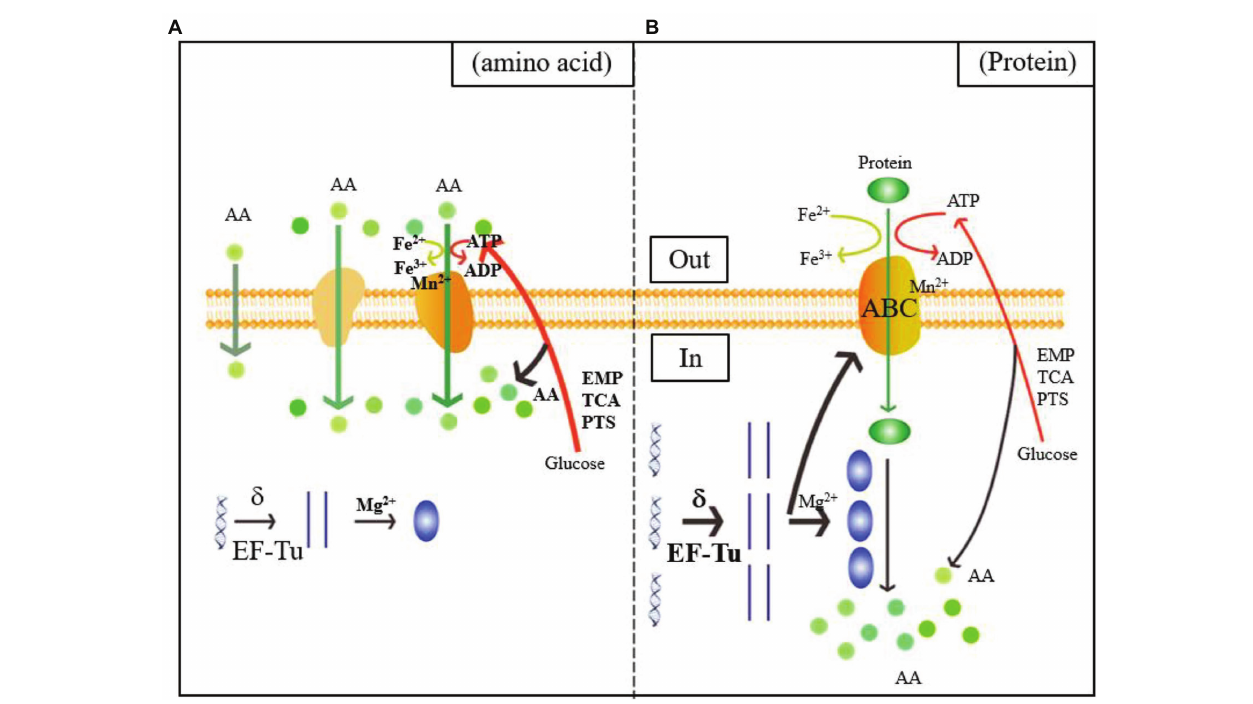
FIGURE 4 | Diagram of the mechanism of the utilization of amino acids (A) and proteins (B) by Lactobacillus helveticus CICC22171. The orange color represents the membrane structure, which includes the phospholipid bilayer, the passive and active transport transporters, and the ATP-binding cassette (ABC) transporters. The boldness of the arrows and the addition of substrates, process enzymes, and products indicate the intensification of the reaction. Green represents the transport of nitrogen sources, spherical represents amino acids, and green ellipse represents proteins. Blue is the central rule. The blue helix is DNA, the straight strand is mRNA, and the blue ellipse is protein. Red indicates carbon source metabolism, ATP transport and amino acid production. The yellow color shows the Fe ion conversion of the electron respiratory